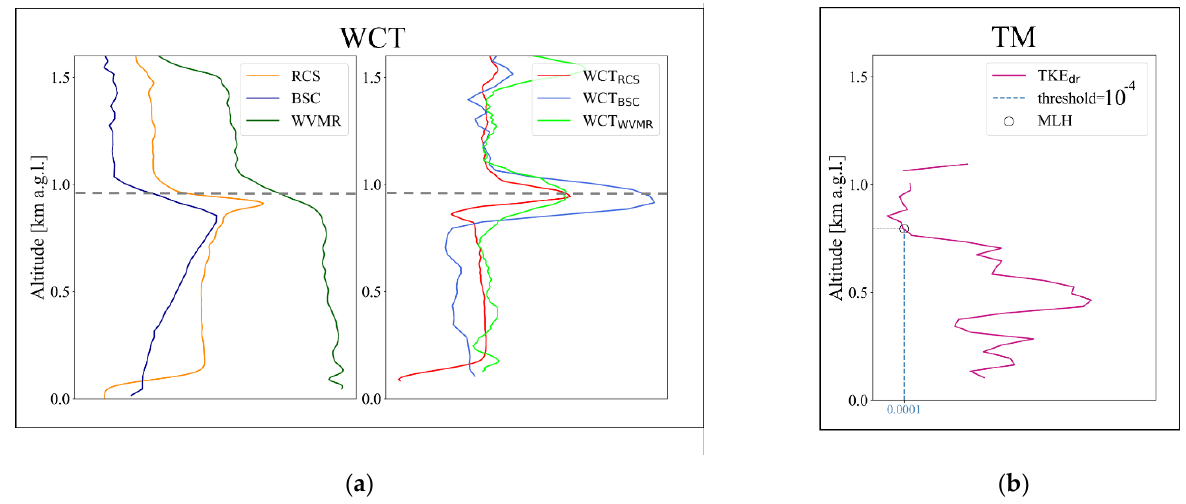
Figure 3. 10 April 2017 01:30 UTC ( a ) WCT Method: Range Corrected Signal (orange line), attenuated Backscatter Coefficient (blue line) and Water Vapor Mixing Ratio (green line) on the left, Wavelet Signal Profiles (red, light blue, light green line for each parameter, respectively) on the right. ( b ) Threshold Method (TM): Turbulent Kinetic Energy dissipation profile (purple line) and vertical line (blue dashed) at the set threshold 10 −4 .